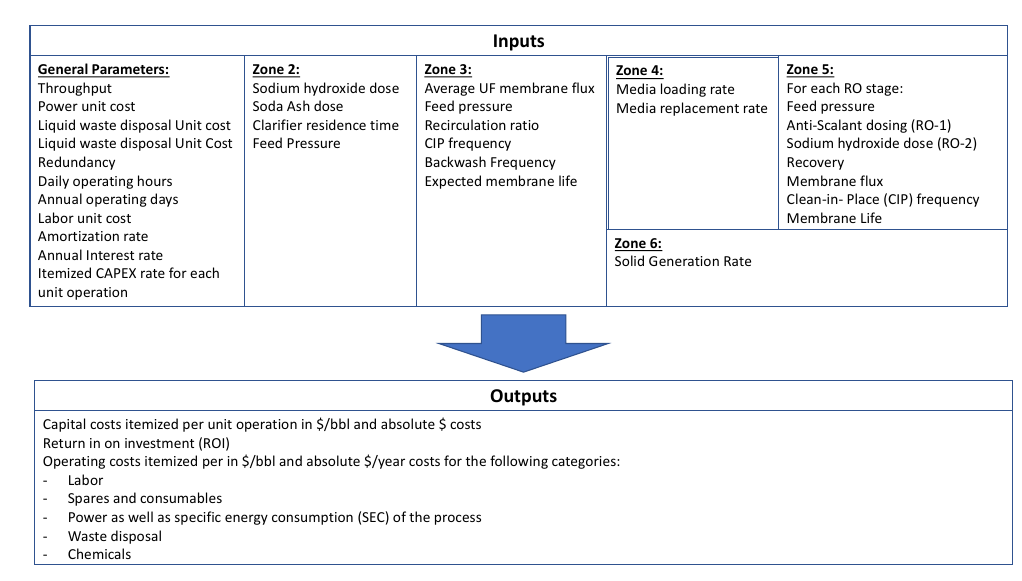
Figure 4. Economic model workflow diagram. CAPEX: capital cost. Table 9. General scale up assumption.